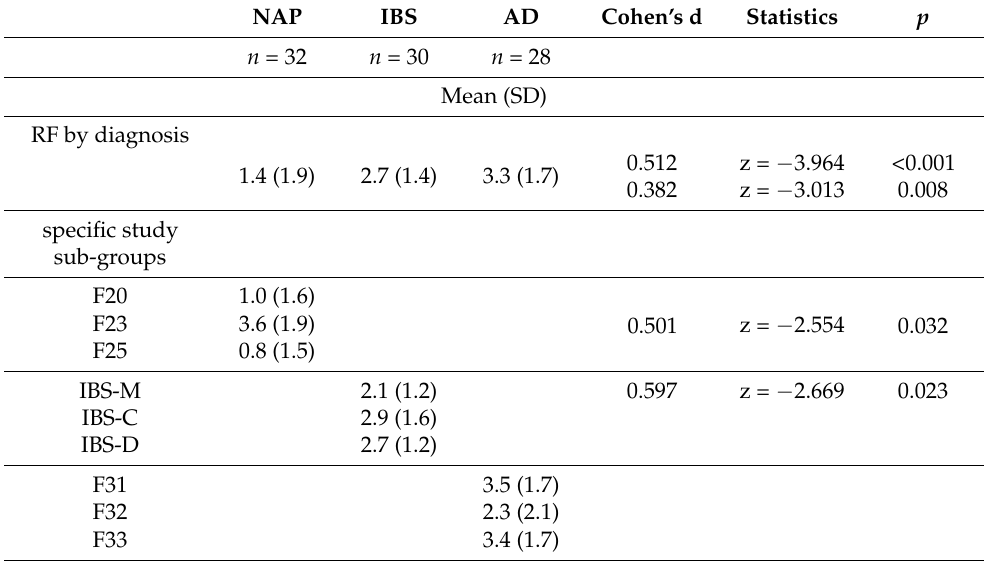
Table 2. Reflective functioning of the groups ( N =